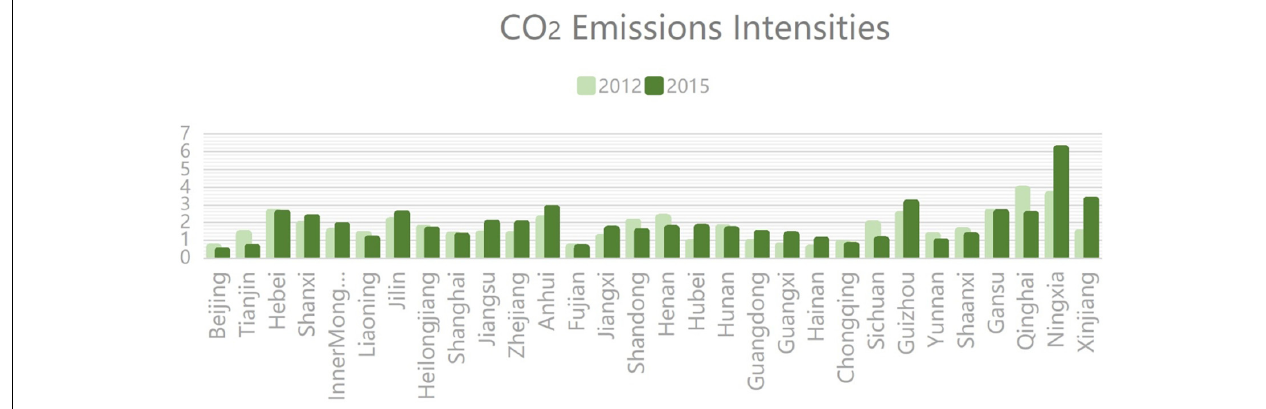
FIGURE 2 | Carbon intensities in 2012 and 2015. TABLE 1 | CO 2 emissions and transfer calculation of 30 province in China in 2012 and 2015 (Unit: Mt). Region 2012 Intermediate products Final